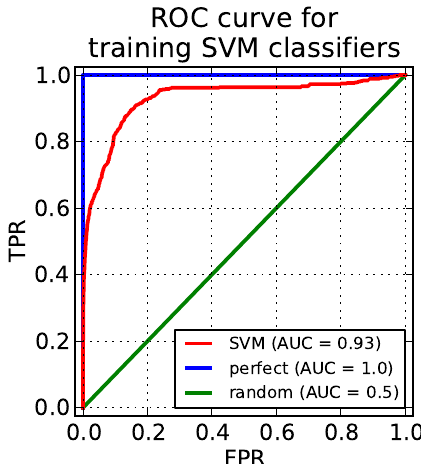
Fig. 6. Receiver operating characteristic for the bootstrapped set of individual SVM classifiers assessed using holdout test data. SVM training parameters ( γ = 0 . 1 , C = 3 ) are chosen to maximize the area under the ROC curve.